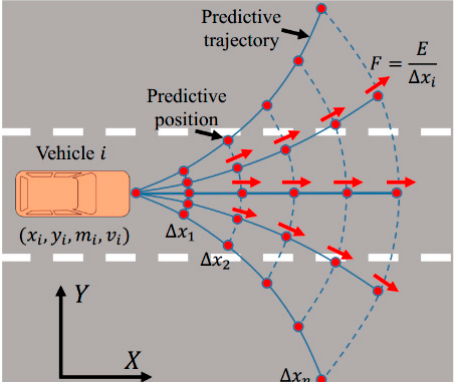
Figure 1. Predictive trajectories and positions diagram. The blue curve denotes the predictive trajectory, and the red point means the predictive position. Moreover, the predicted trajectories and points are generated under the assumption that the steering angle is constant. The red arrow indicates the equivalent force at each position. Δ𝑥 is not only indicates the linear distance between vehicle 𝑖 and others in a longitudinal direction but also denotes the arc length as shown in this figure.